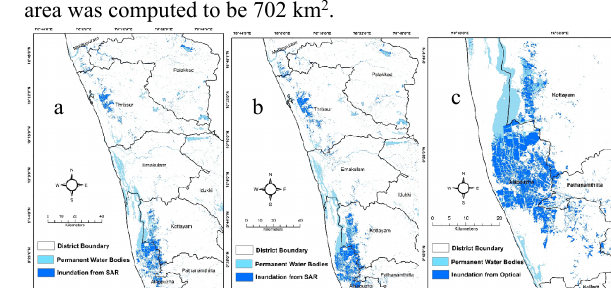
Figure 11 a, b and c. Flood inundation map obtained from remote sensing data (SAR and cloud free optical data of Sentinel-1, 2).